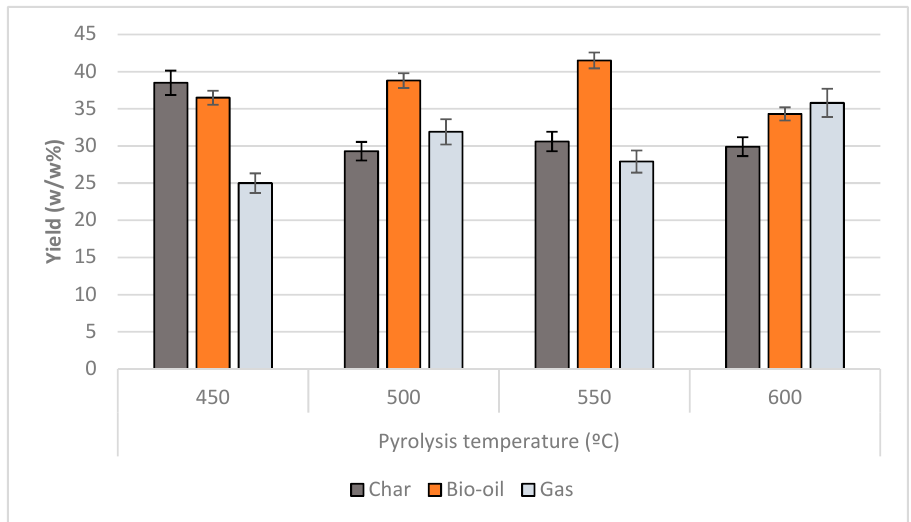
Figure 2. Variation of product yields with pyrolysis temperature for pine dust .